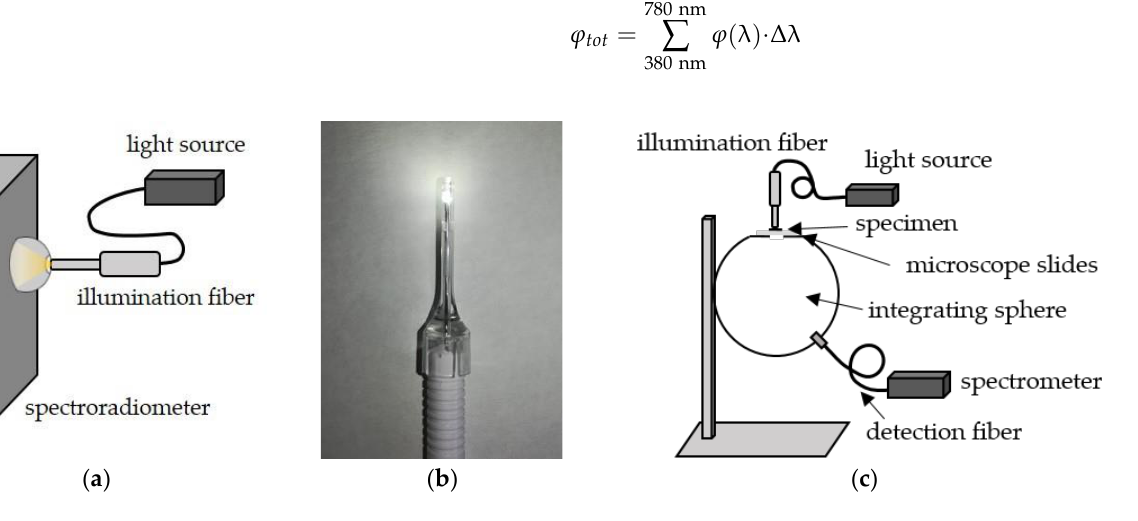
Figure 1. ( a ) Set-up for luminous flux measurement. The emitted light from the illumination fiber entered the aperture of the integrating sphere of the spectroradiometer. ( b ) Diaphanoscopic illumination fiber with scleral depressor. ( c ) Set-up for transmission measurement. The light from the diaphanoscopic illumination fiber was transmitted through the eyewall into the integrating sphere, which is connected to a spectrometer.